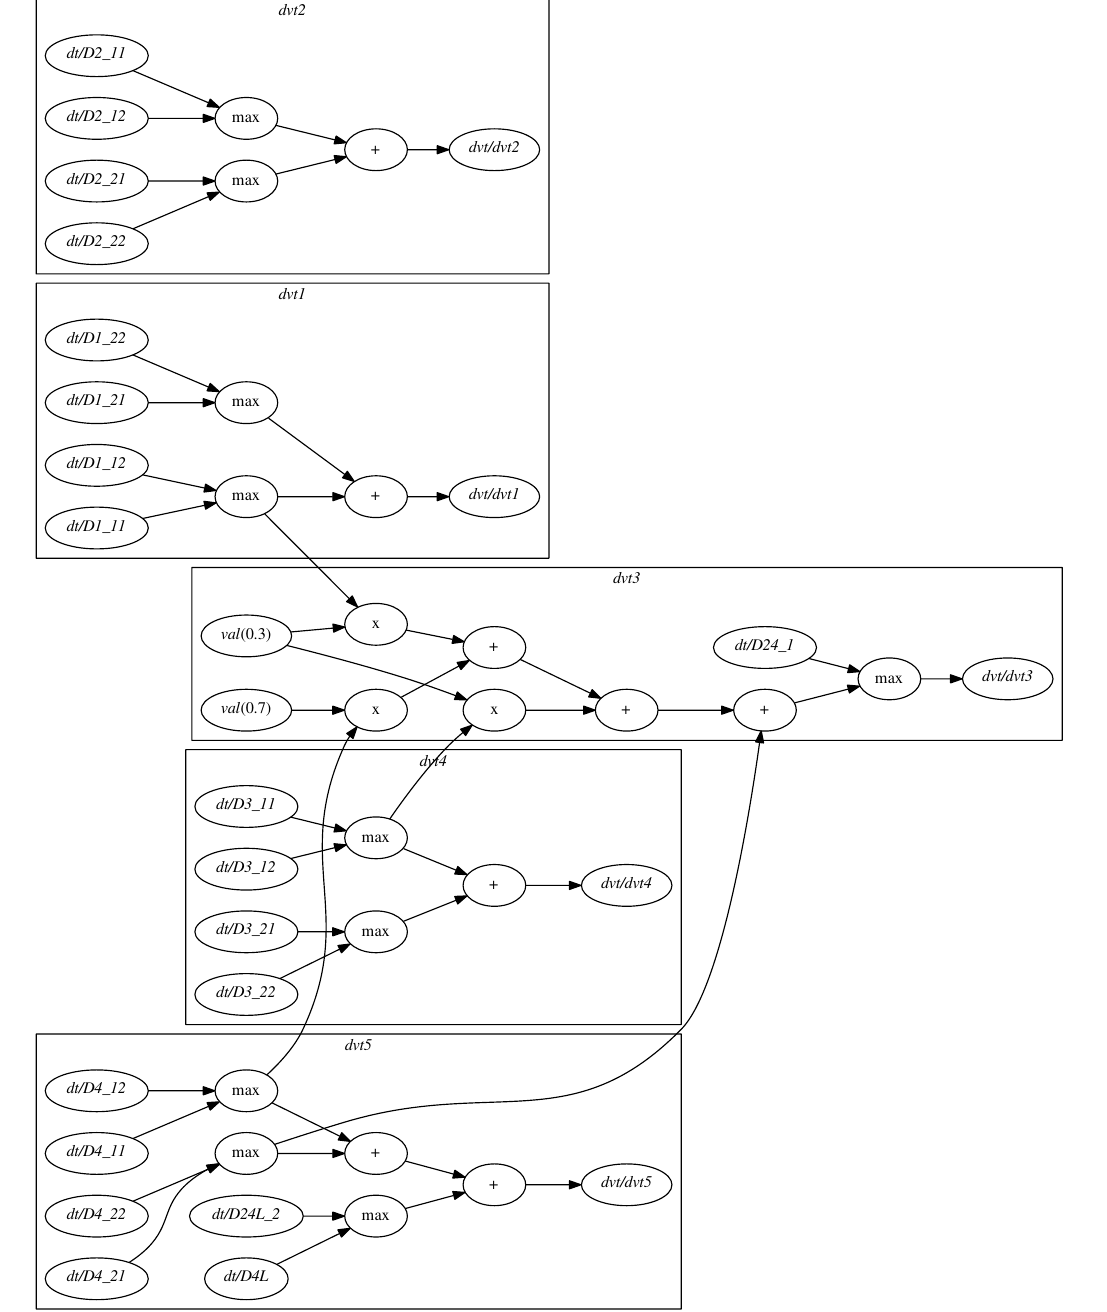
Figure 10. An example intersection, Krakow, Poland; DSG Θ complying with the Θ (evaluation)